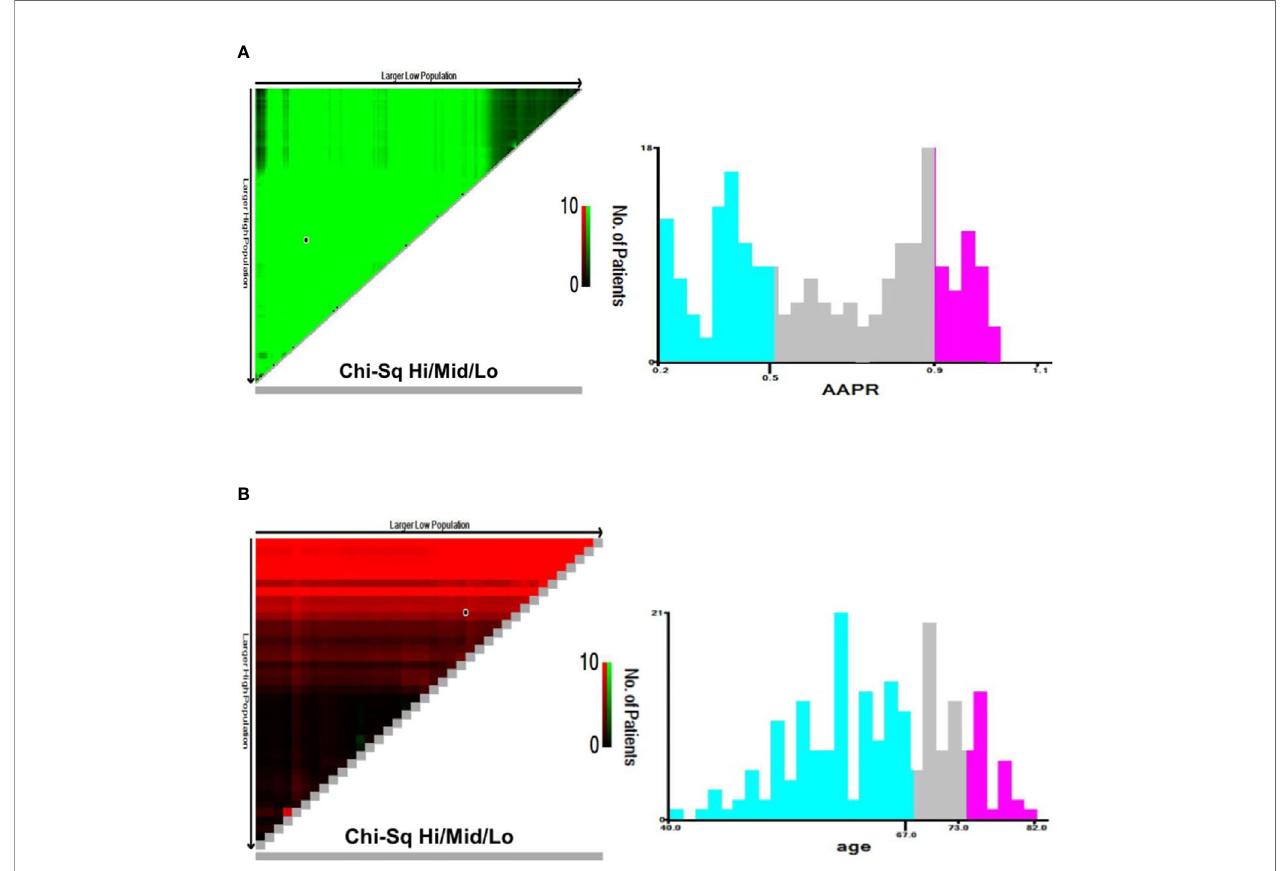
FIGURE 2 | X-tile analyses of OS based on patient data to determine the optimal cut-off values for AAPR (A) and age (B) . The optimal cut-off values are shown in histograms of the entire cohort. OS, overall survival; AAPR, albumin-to-alkaline phosphatase